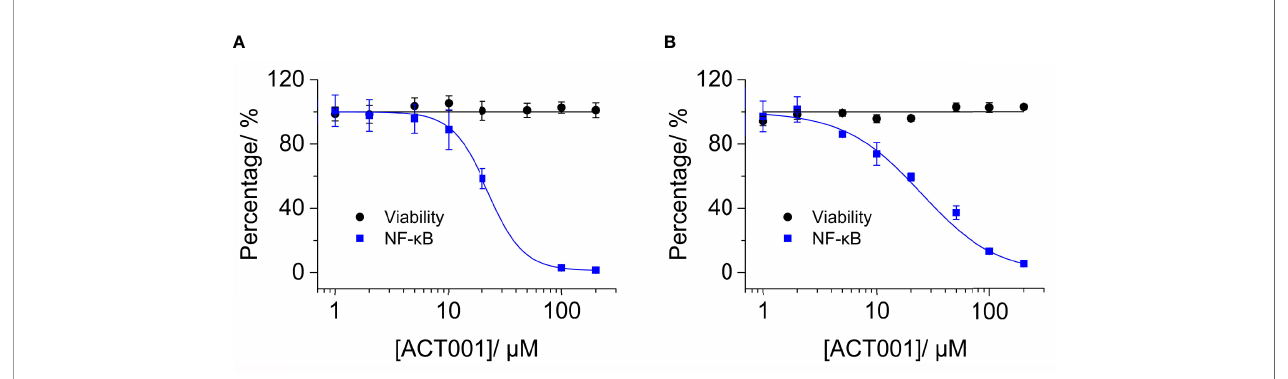
FIGURE 4 | ACT001 inhibits LPS-induced NF- k B activation. (A) HEK Blue TLR4 293 cells, which over-express human CD14, TLR4, and MD2, were stimulated with 20 ng/mL LPS and indicated concentrations of ACT001. The NF- k B activity was determined by SEAP assay and cellular viability was measured by CCK-8 Kit. (B) BV-2 NF- k B luciferase reporter cells were treated with 200 ng/mL LPS and the indicated concentrations of ACT001. After 24 h of incubation, the NF- k B activity was determined by the Dual-Glo luciferase assay and cellular viability was measured by crystal violet staining. All experiments were performed 3 times independently and data were given as the mean ±